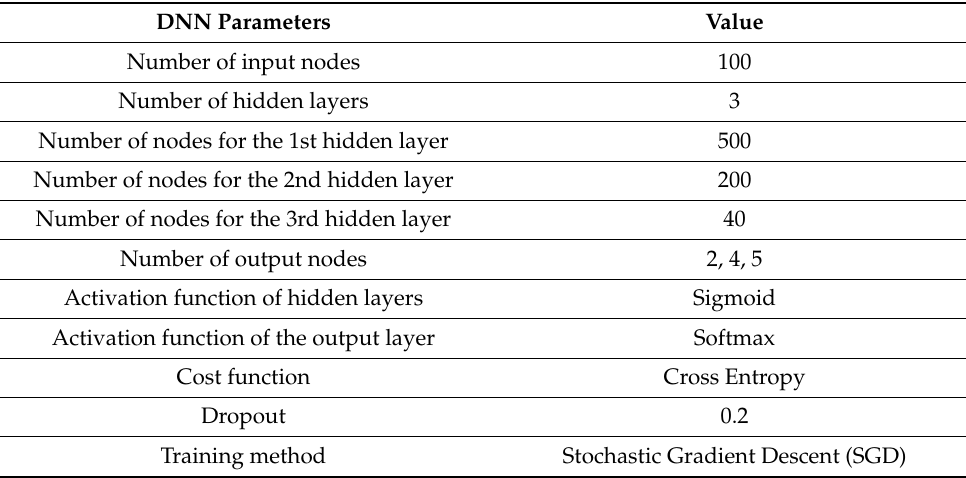
Table 3. Structure of DNN for performance evaluation .